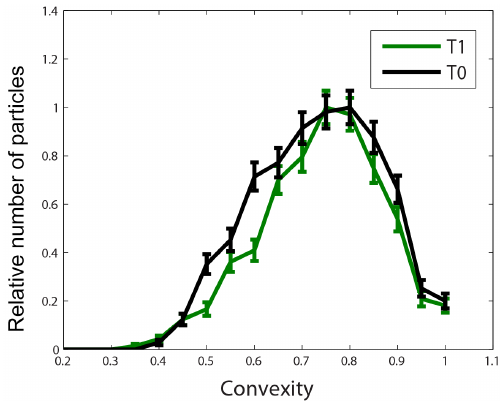
Figure 5. Histograms of BC inclusion convexity for the T0 and T1